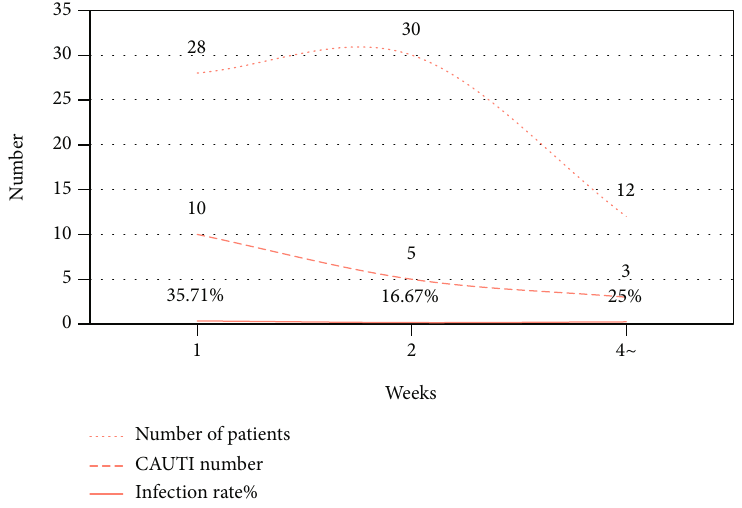
Figure 3: The e ff ect of catheter replacement time on CAUIT. Table 4: The impact of underlying diseases on CAUIT. Type of